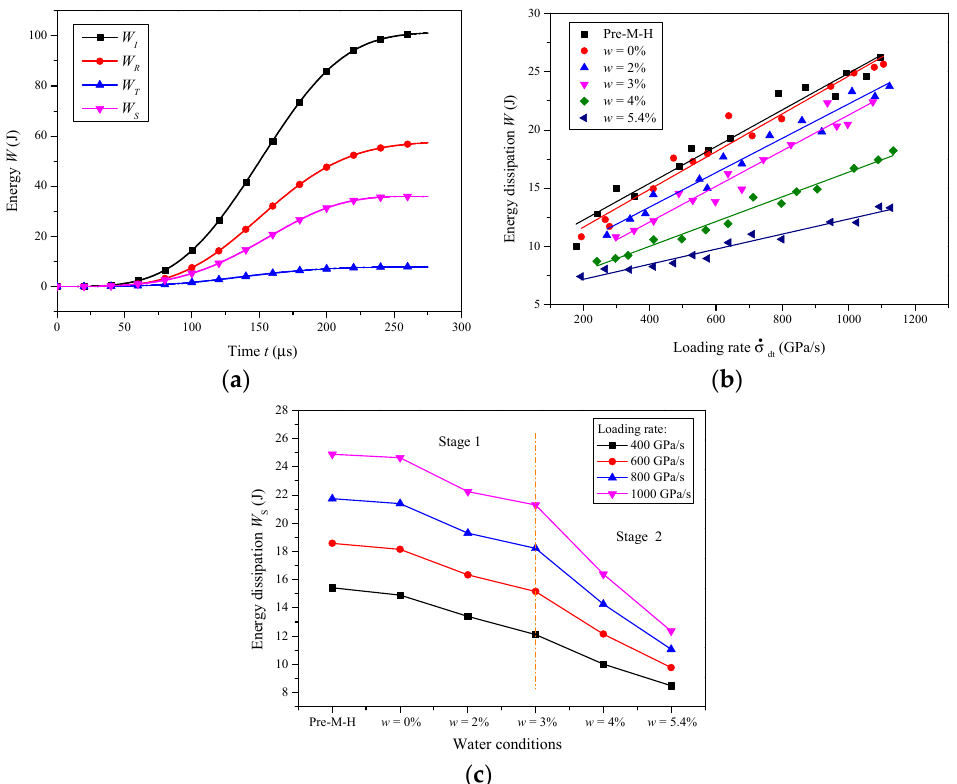
Figure 21. Energy analysis of sandstone after microwave irradiation: ( a ) typical energy-time curve of sample under dynamic loading; ( b ) energy dissipation vs. loading rate; ( c ) energy dissipation vs. water content.